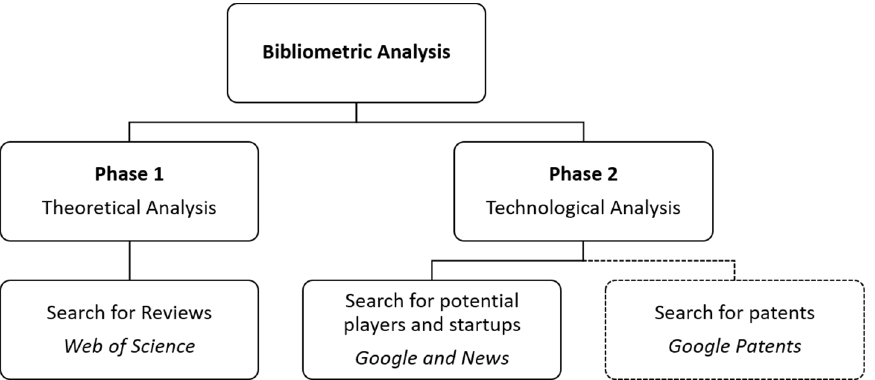
Figure 5. Flowchart of the proposed bibliometric search approach.